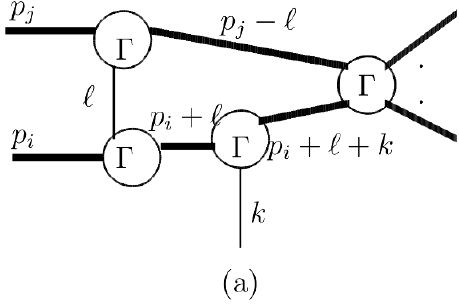
Figure 7 . An apparently infrared divergent contribution to (cid:12)gure